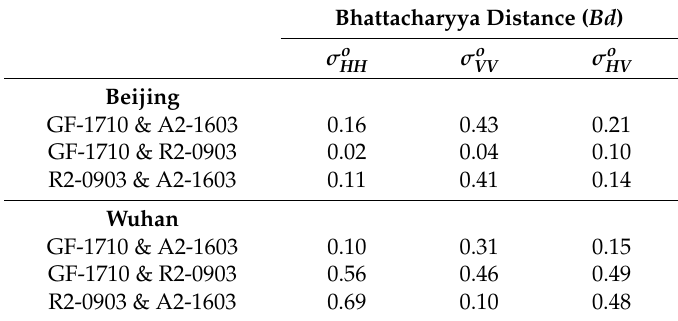
Figure 4. Histograms of GF-1703, A2-1603, and R2-0903 of 𝜎 (cid:3009)(cid:3009)(cid:3042) ( a – c ), 𝜎 (cid:3023)(cid:3023)(cid:3042) ( d – f ), and 𝜎 (cid:3009)(cid:3023)(cid:3042) ( g – i ) in Beijing. Table 3. Similarity of backscattering coefficients for GF-3, ALOS-2, and RADARSAT-2.